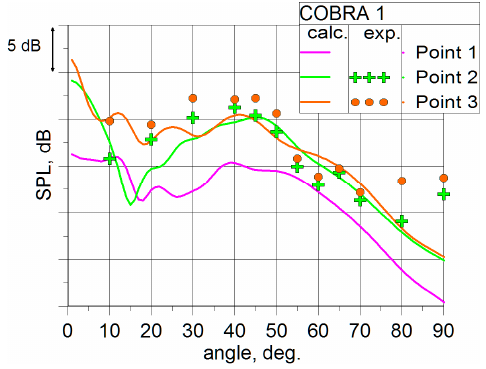
Figure 43. Comparison of sound pressure level (SPL) obtained in the calculations and in the tests for different operational points for COBRA1 fan.